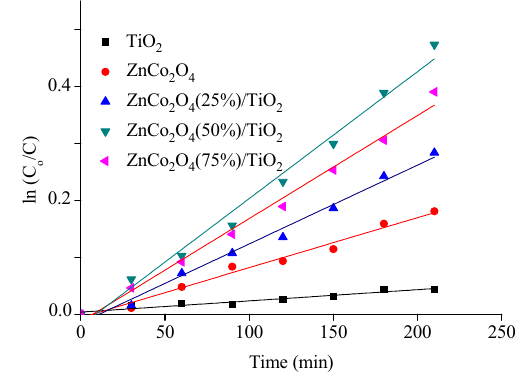
Fig. 7 The photocatalytic evolution of HCrO 4− reduction (8 mg L −1 ) 2 O 4 /TiO 2 /electrolyte junc- for various catalyst doses